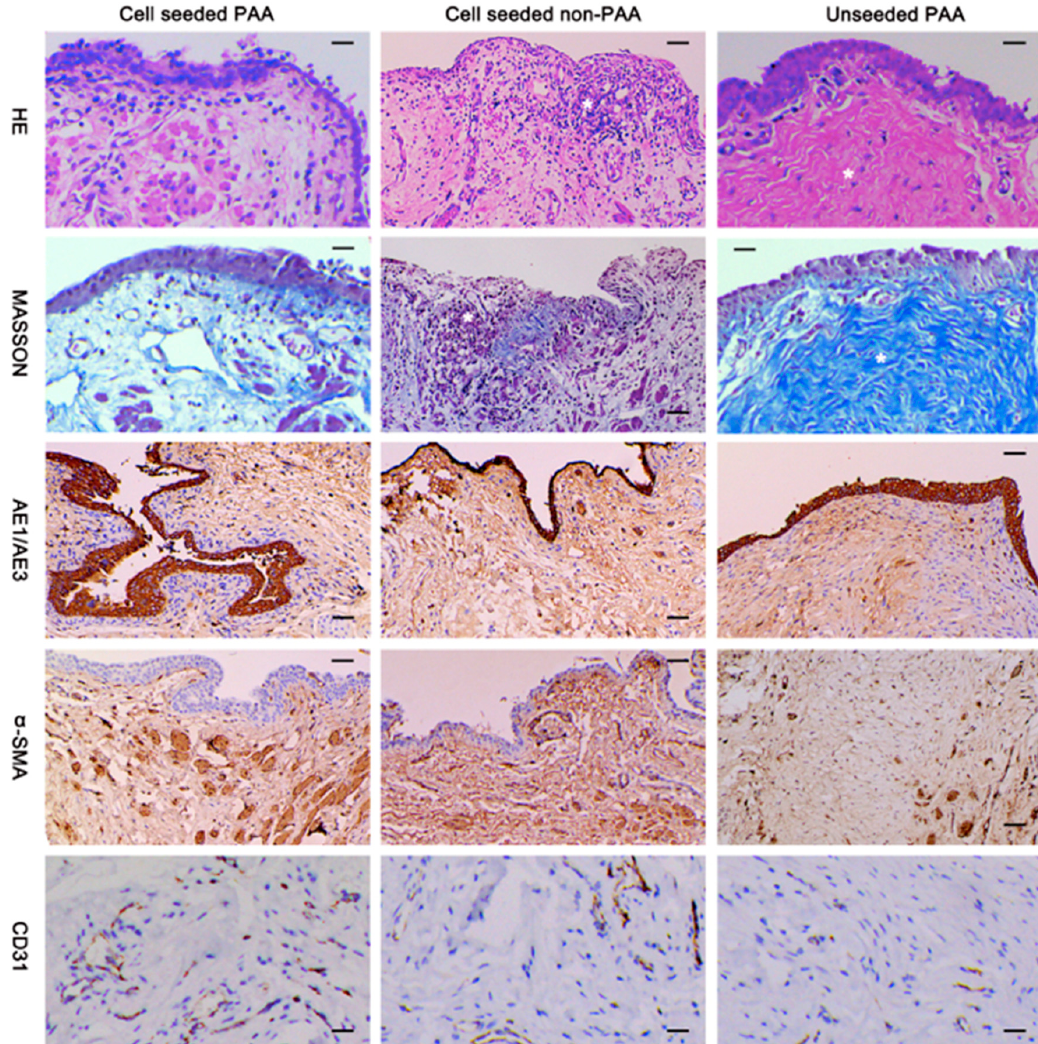
Figure 3. Histological and immunohistochemical assessment of urethral reconstruction in animals using cell-loaded, decellularized SIS scaffolds (Cell seeded PAA) showing regrowth of layers of transitional epithelium, more smooth muscle, and vessels in contrast to the cell loaded but non-decellularized (Cell seeded non-PAA) and non-loaded, decellularized scaffolds (Unseeded PAA). Scale bar = 20 µ m. (reproduced with permission from [68]). © 2016 Zhang et al